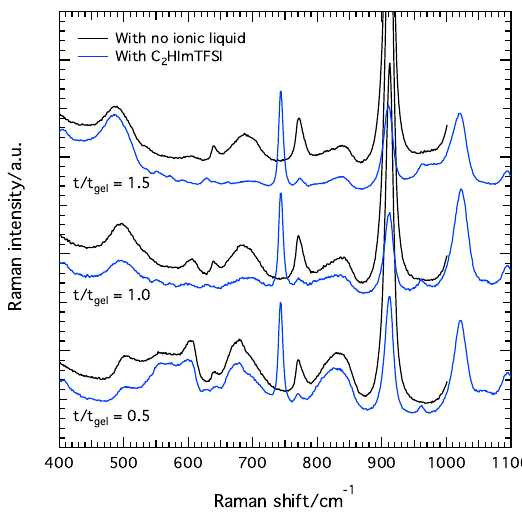
Figure 5. Raman spectra recorded in solutions/gels with (blue) and without (black) the ionic liquid C HImTFSi at different reaction times, i.e ., at t/t 2